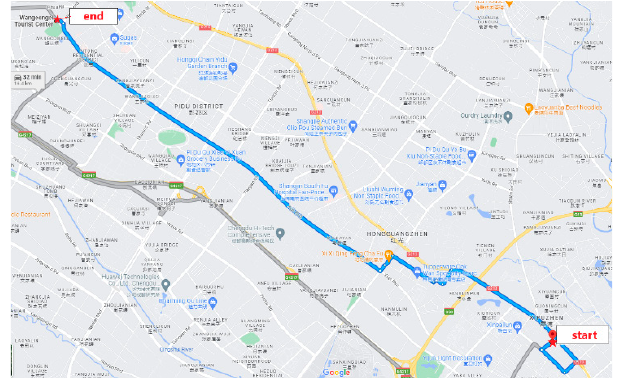
Figure 7. Test roadmap.